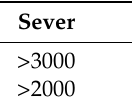
Figure 7. The salinity hazard (EC and TDS) values for the groundwater samples. Table 8. Restriction degree for agriculture irrigation.